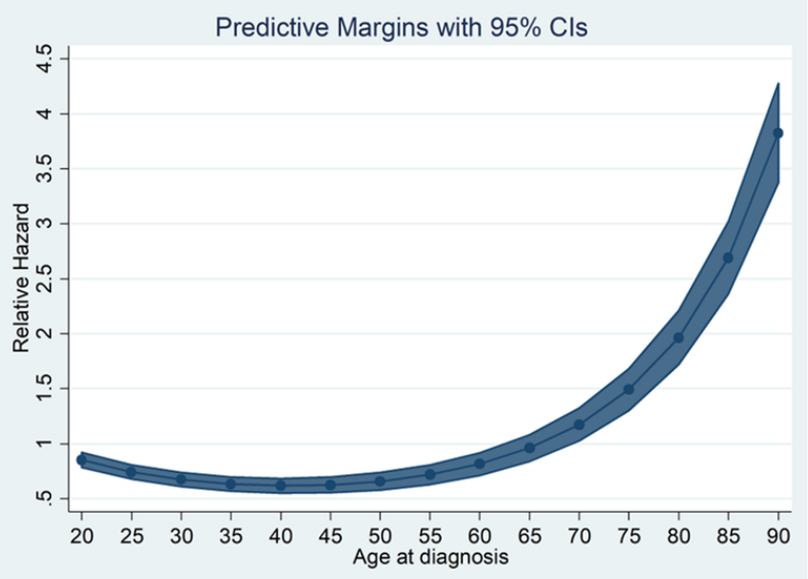
Figure 1. Relative Hazard (RH) of death as a nonlinear function of age at diagnosis. The RH is adjusted for other confounders. RH is high at a younger age and begins to decrease until age 50 at which point there is a gradual then sharp increase in the RH of death. RH was determined from overall survival (OS). CIs = Confidence intervals.